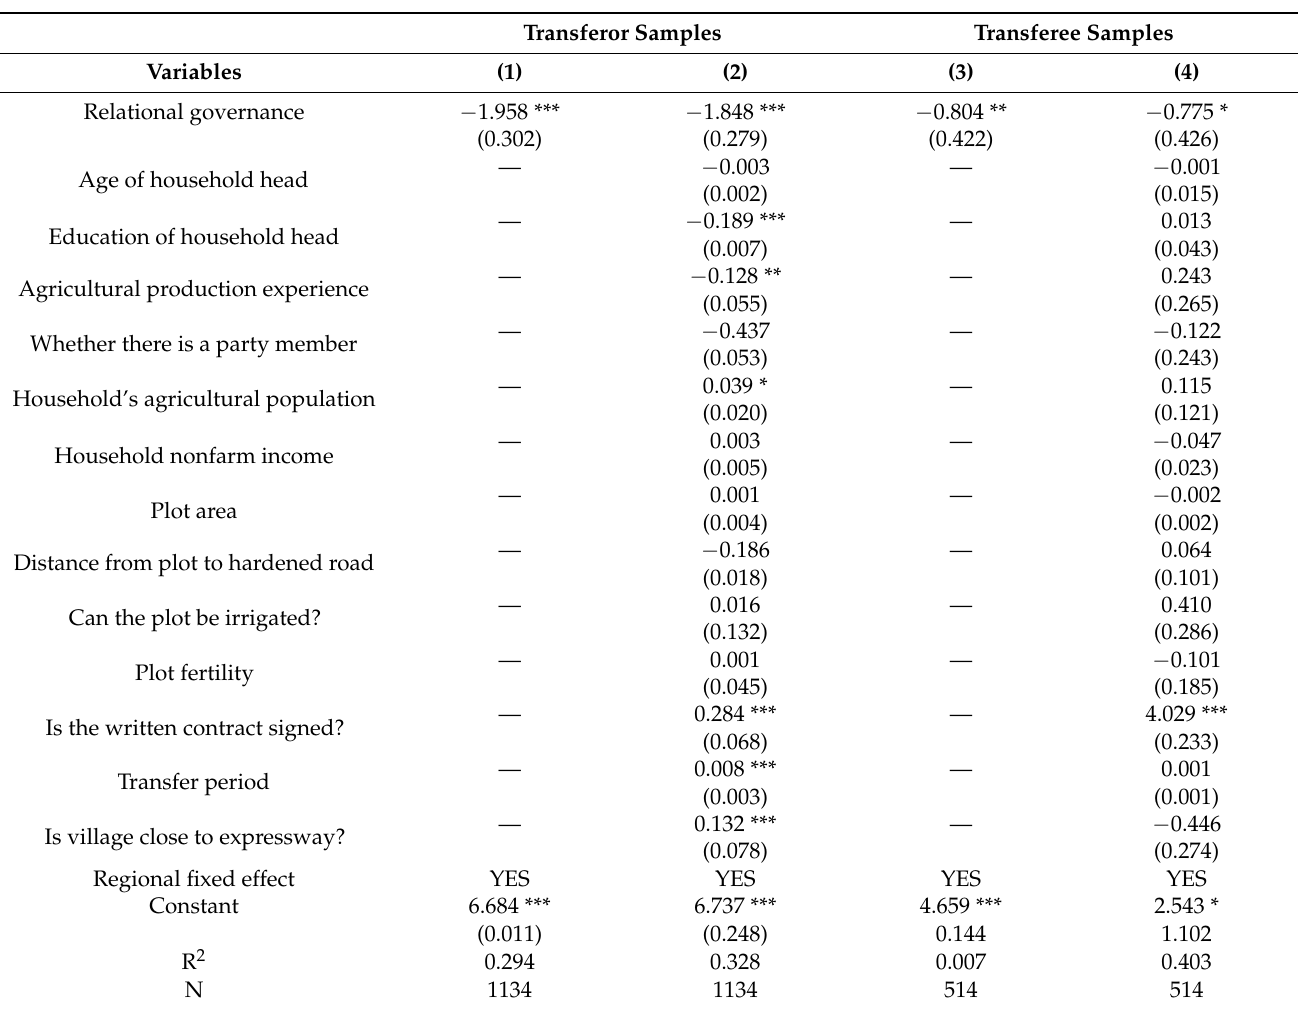
Table 5. Impact of relationship governance on transfer rent: OLS. Transferor Samples Transferee